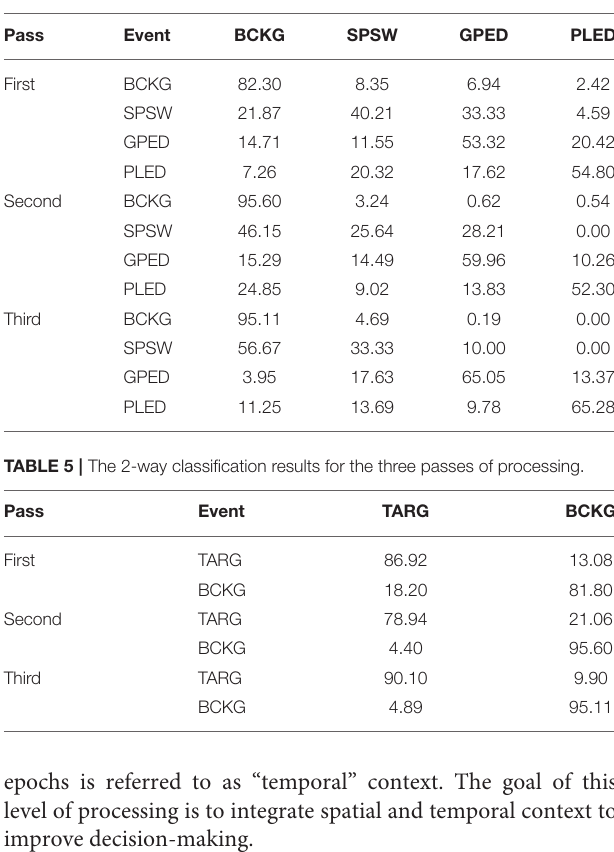
TABLE 4 | The 4-way classification results for the three passes of processing.